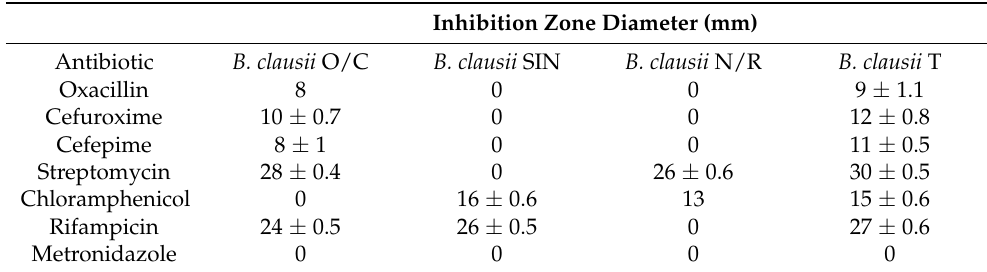
Table 1. Antibiotic resistance profiles of the B. clausii strains O/C, SIN, N/R, and T to some of the antibiotics tested in [29].